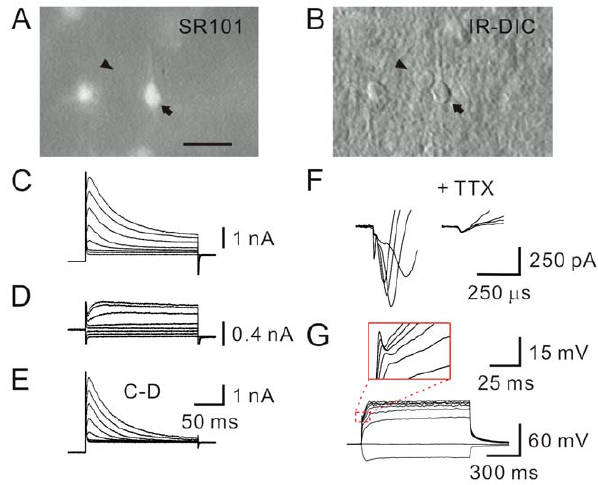
Figure 1. Identification of NG2-expressing cells in the hippo- campus. (A) Epifluorescence image showing an SR101( + ) cell (arrow) in the stratum radiatum of the CA1 area. Arrowhead, an SR101( 2 ) cell, a putative NG2 cell, which was visible under IR-DIC optics in (B). Scale bar, 10 m m. (B) IR-DIC image of (A). (C) Total outward K + currents recorded from an NG2 cell evoked by step voltages (20 mV, 200 ms) from 2 80 mV to + 40 mV with an 1-s prepulse ( 2 120 mV). (D) Delayed- rectifier K + currents evoked in the same cell by the same step voltage protocol in (C) with an 1-s prepulse ( 2 30 mV). (E) A-type K + currents obtained by subtracting (D) from (C). (F) Left, representative inward Na + currents evoked by step voltages (20 mV, 200 ms) from 2 10 mV to + 50 mV with an 1-s prepulse ( 2 120 mV). Right, after addition of TTX (0.5 m M). (G) Voltage responses to the current injection ( 2 100 pA to + 600 pA; step, 100 pA).